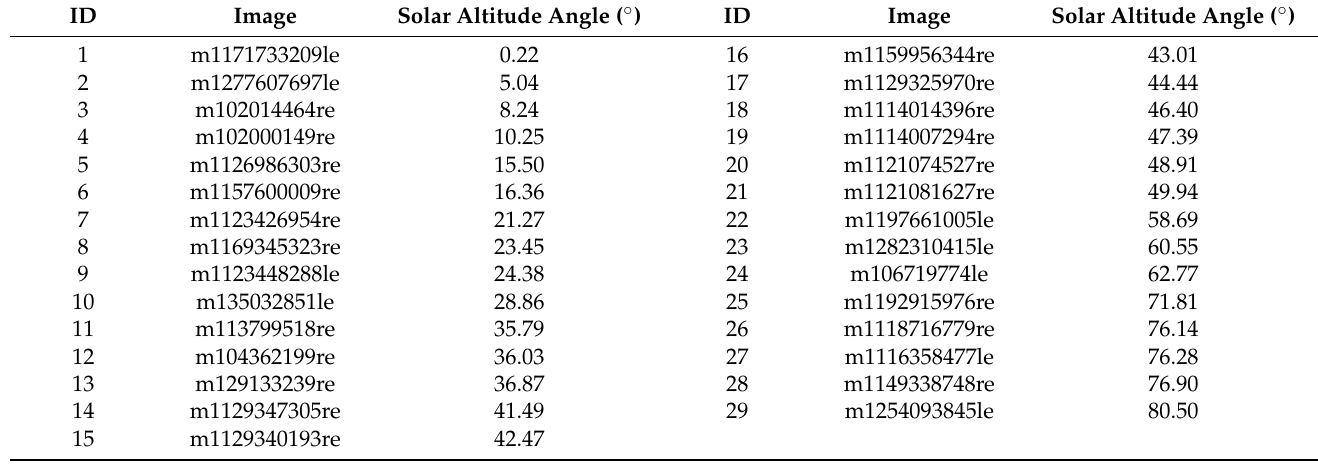
Table 4. Solar altitude angle information of the experimental images used for testing influence of light conditions.